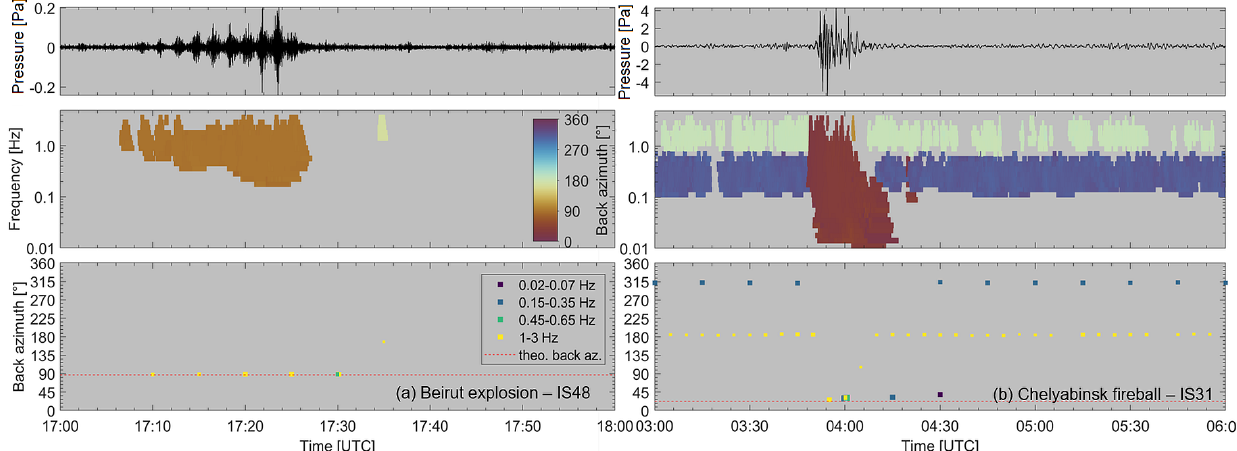
Figure 8. Waveform beam (top), PMCC result (center), and data products for (a) the Beirut explosion detected at IS48, Tunisia (2450km distance), on 4 August 2020 and (b) the Chelyabinsk fireball detected at IS31, Kazakhstan (540km), on 15 February 2013. The waveform beams correspond to the theoretical back azimuths and third-order Chebyshev bandpass filters (0.5–4 and 0.02–2Hz, respectively). The legends of panel (a) apply to panel (b) too. The relative marker size of the products (bottom panels) depicts Q . The dashed red lines depict the theoretical back azimuths from an array to the source. It is of note that the mb_lf and hf signatures caused by the fireball interrupt the series of IS31 detections from a northwesterly direction ( ∼ 315 ◦ ), most likely microbaroms, and from a southerly